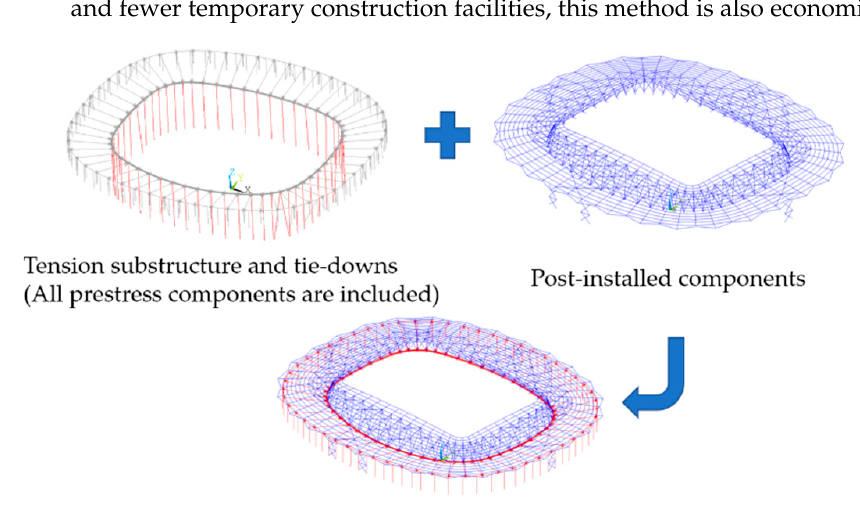
Figure 5. Prestress flow control process.